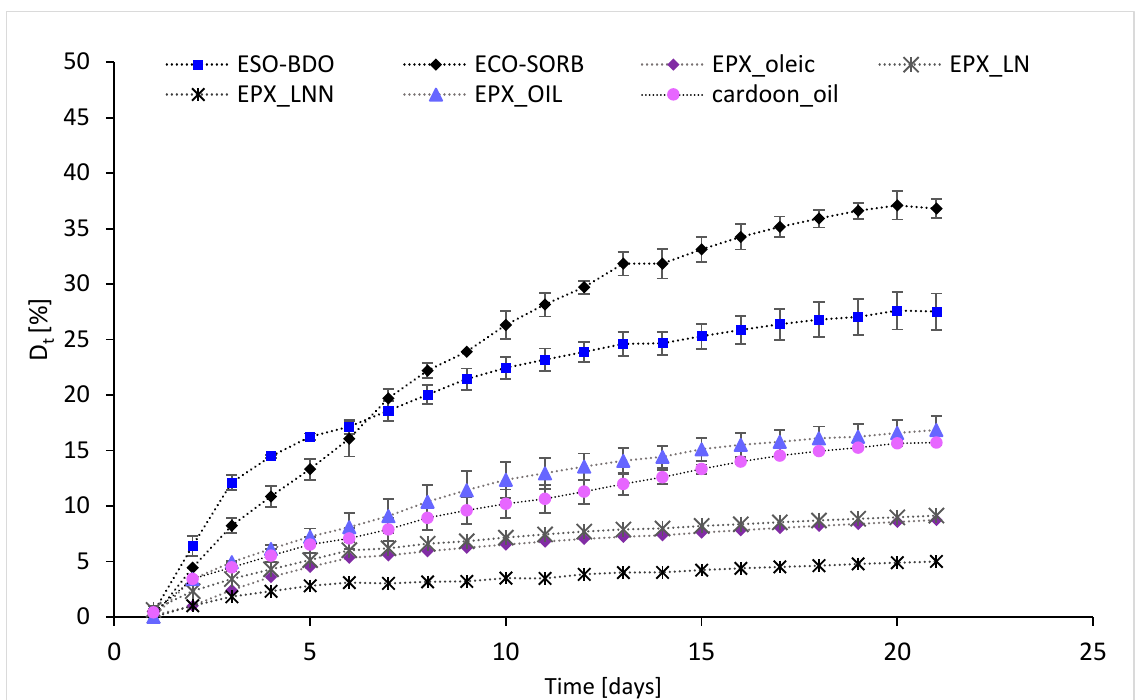
Figure 7. Degree of degradation of the epoxy cardoon oils and their derivatives after 21 days of incubation in a marine environment; the data were normalized by subtracting the values of the control samples.